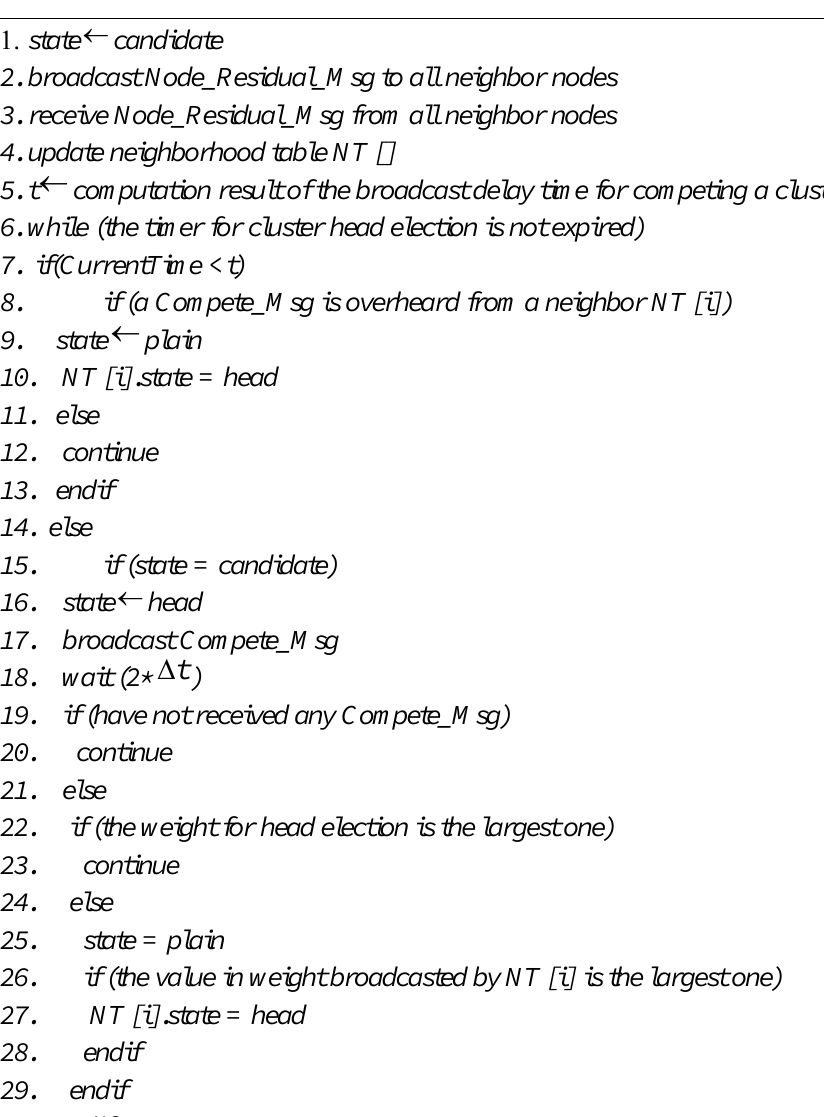
Figure 4. The Pseudo Clustering